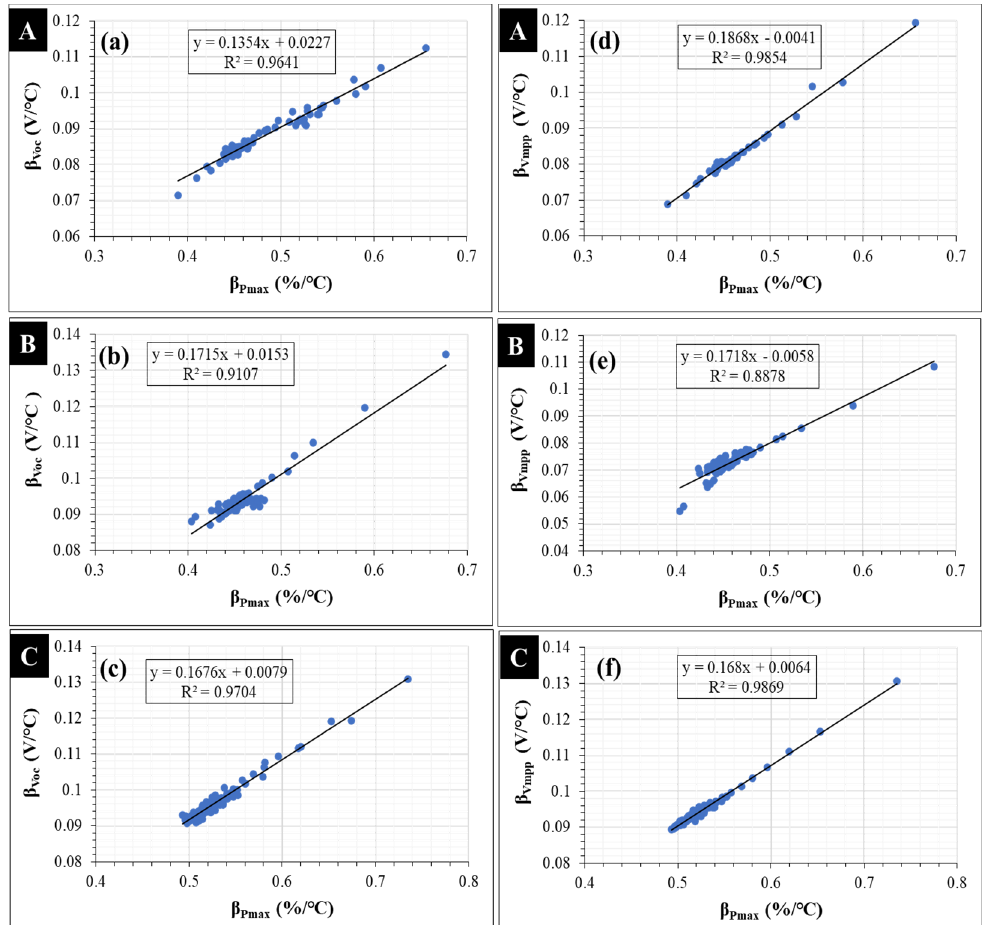
Figure 9. Dependence of absolute β Pmax on absolute β Voc ( a – c ) and β Vmpp ( d – f ) of the 3 solar panels affected by PID. R 2 indicates the degree of correlation.